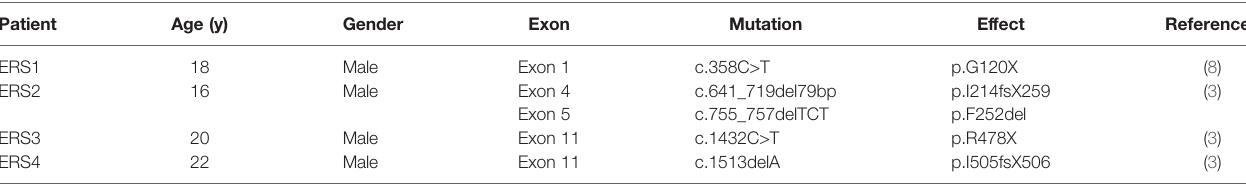
TABLE 1 | FAM20A mutations in ERS